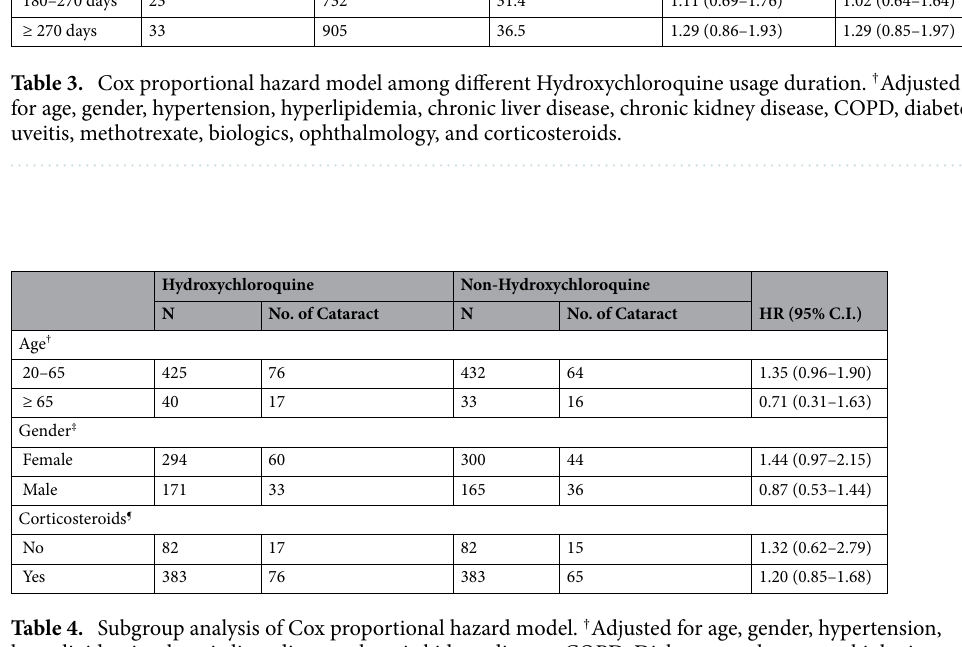
Observed person- years